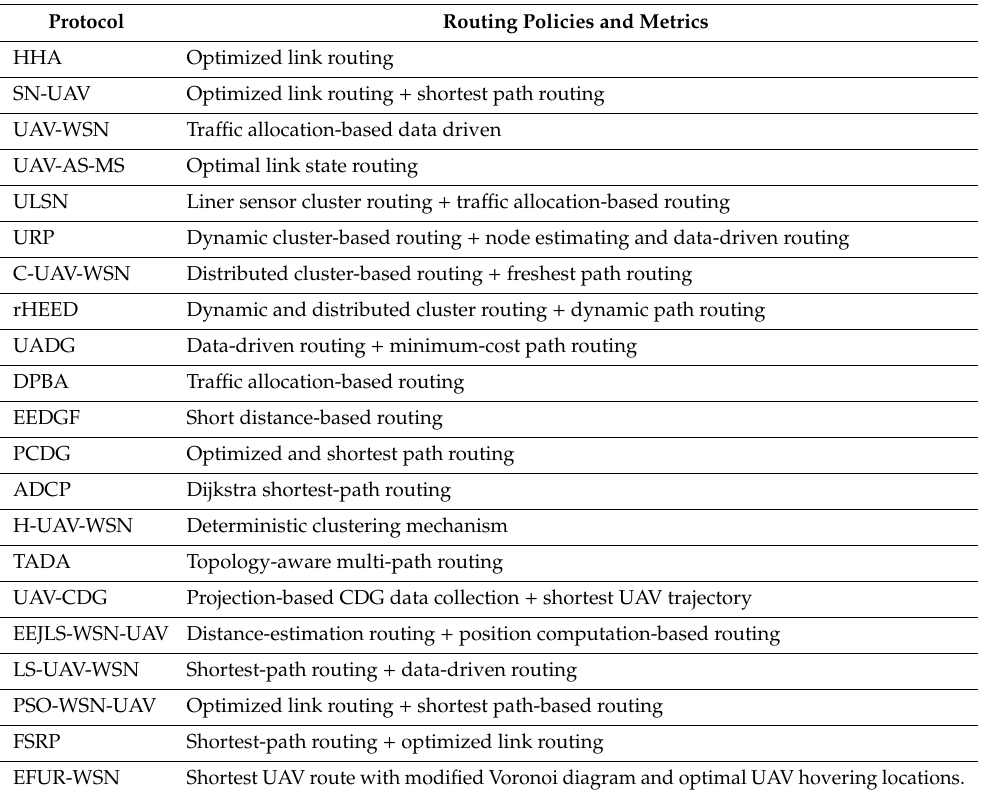
Table 2. Routing policies and metrics for